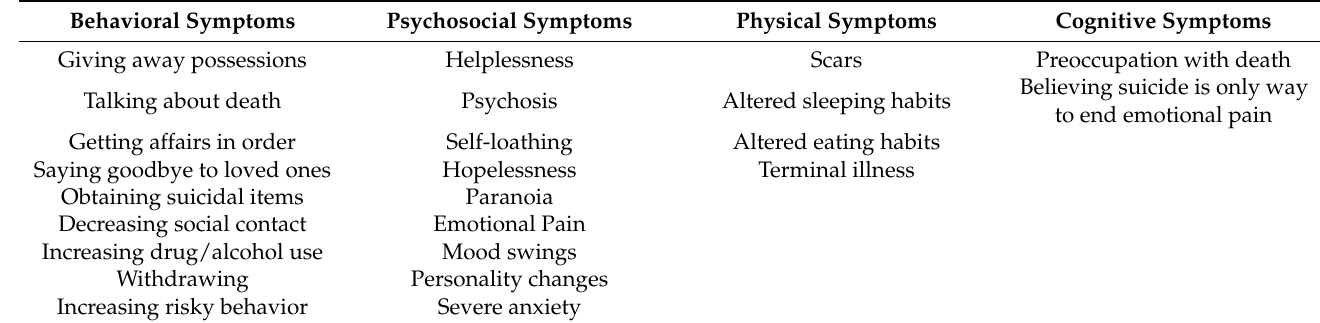
Table 1. Symptoms of Suicidal